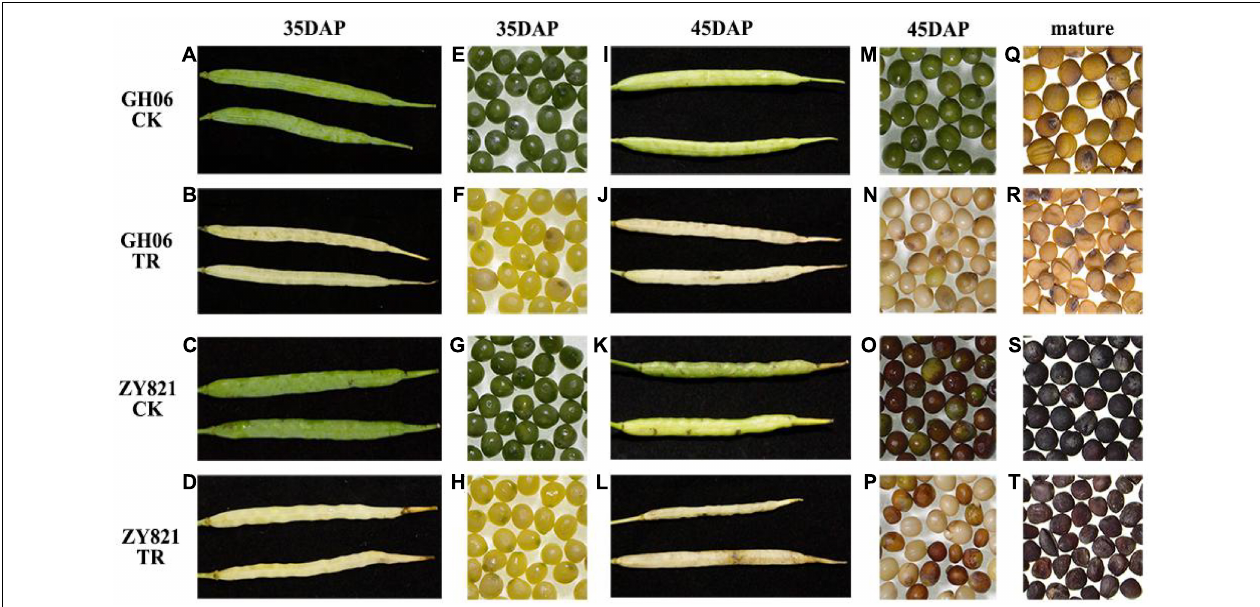
FIGURE 1 | Phenotypic analysis of the siliques and seeds of rapeseed under different conditions. Siliques of GH06 and ZY821 under control (A,C) and shading (B,D) at 35DAP. Seeds of GH06 and ZY821 under control (E,G) and shading (F,H) at 35DAP. Siliques of GH06 and ZY821 under control (I,K) and shading (J,L) at 45DAP. Seeds of GH06 and ZY821 under control (M,O) and shading (N,P) at 45DAP. Mature seeds of GH06 and ZY821 after control (Q,S) and shading treatment (R,T) . CK, the control; TR, shading treatment; DAP, days after pollination. Scale bars = 1 cm.